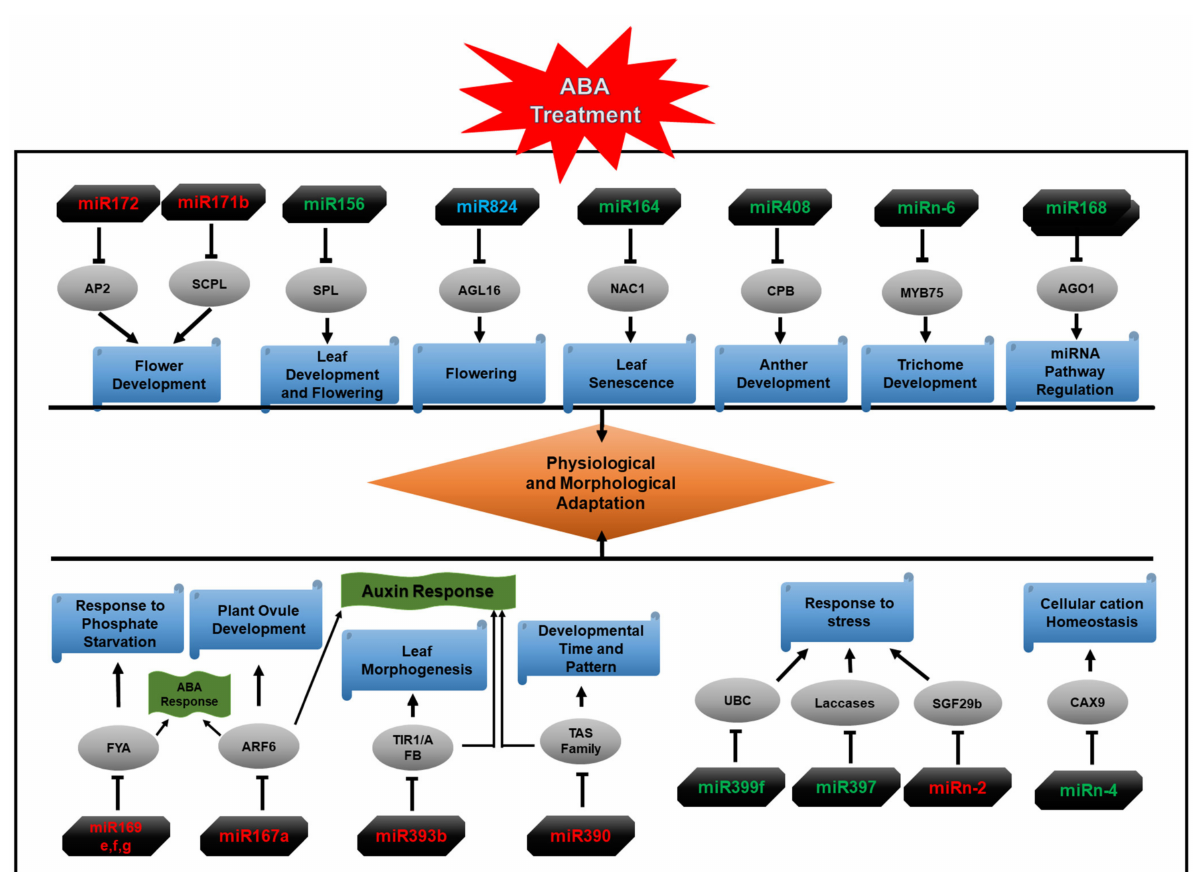
Figure 11. A hypothetical model of regulatory networks of ABA-responsive miRNAs and their target genes in Arabidopsis . Possible roles of known and novel ABA-induced miRNAs in different biological processes in Arabidopsis based on Gene Ontology (GO) analysis. Downregulated ABA-responsive miRNAs are shown in red, while those shown in green represent upregulated ABA-responsive miRNAs identified in this study. miRNAs labeled in green are upregulated in all genotypes; those in red are downregulated in all genotypes; miRNAs labeled in light blue are expressed differently in all genotypes. Grey ovals show target genes of miRNAs. Block/inhibitory arrows show the regulation of target gene by